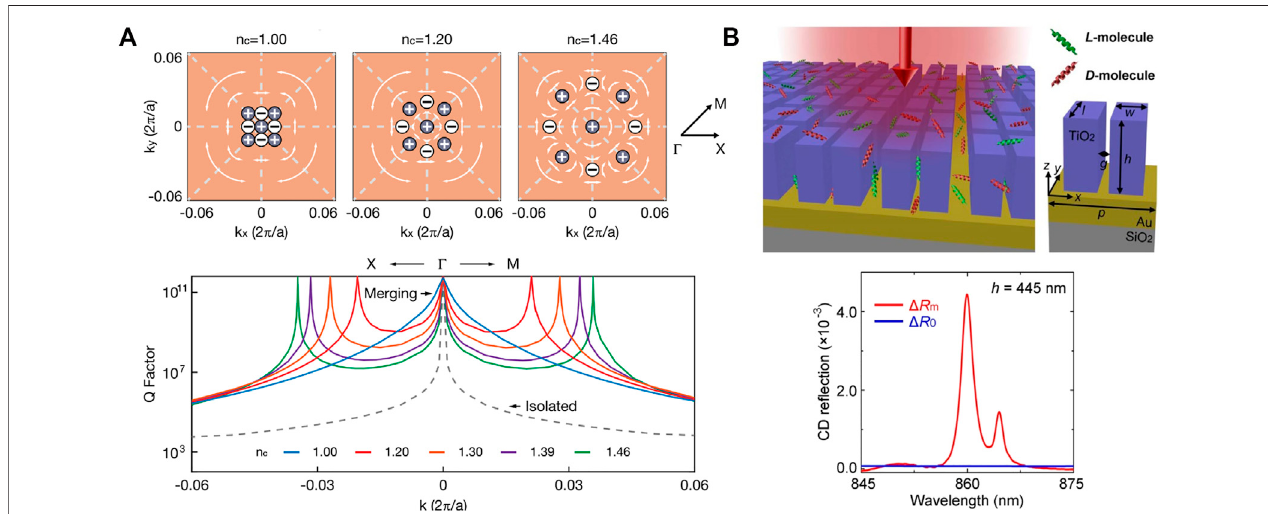
FIGURE 8 | Refractive index and chiral sensing applications. (A) Topological charge evolution of merging BICs and the Q s with refractive index variation [159], copyright IEEE. (B) Comparison of CD re fl ection spectrum of the BICs metasurface enhanced chiral layer and the bare chiral layer [160], copyright American Chemical